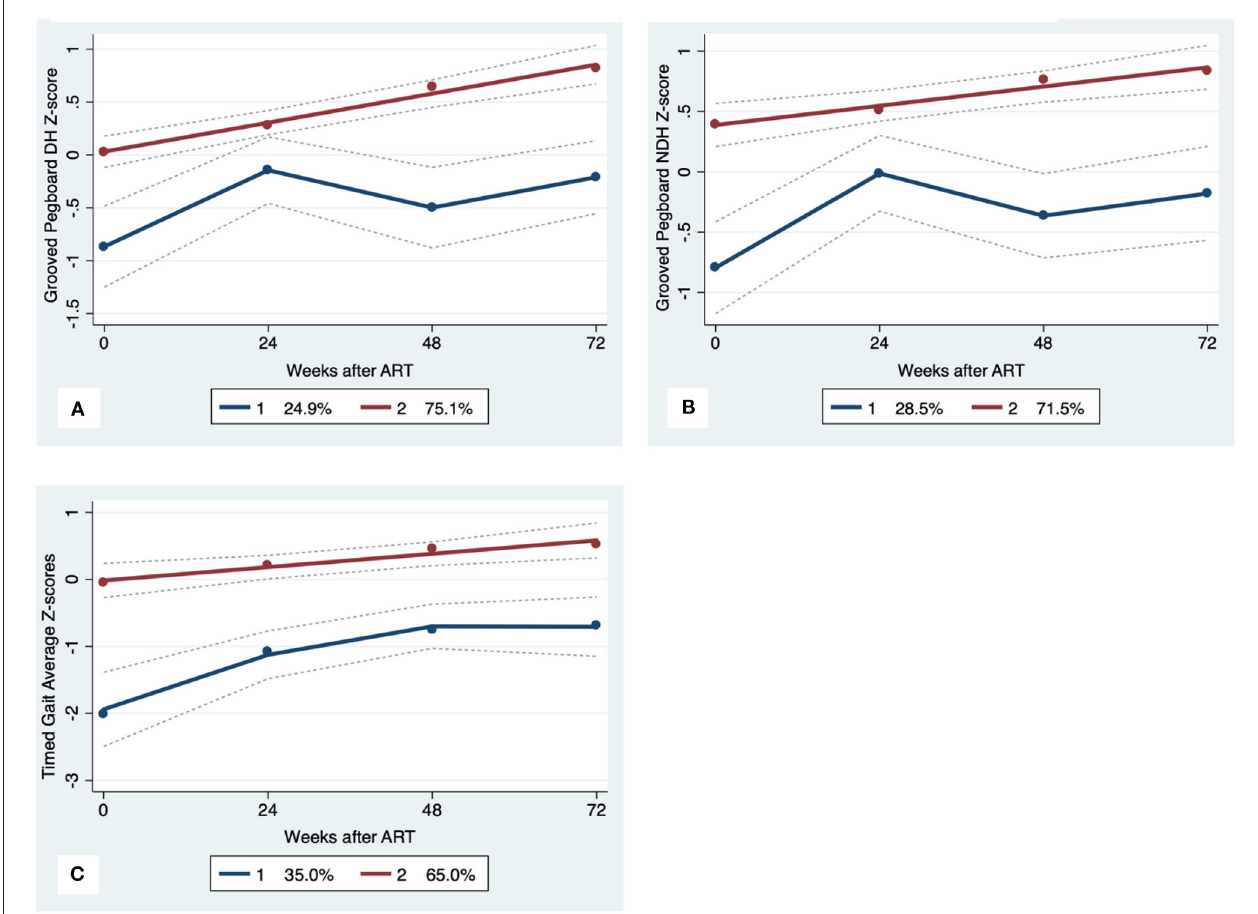
FIGURE 4 | Motor Trajectory subgroups, Solid lines represent estimated trajectories, dot symbols are observed group means at each assessment wave, and dashed lines are 95% pointwise confidence intervals on the estimated trajectories. (A) Grooved Pegboard Dominant Hand, (B) Grooved Pegboard Non-Dominant Hand; and (C) Timed